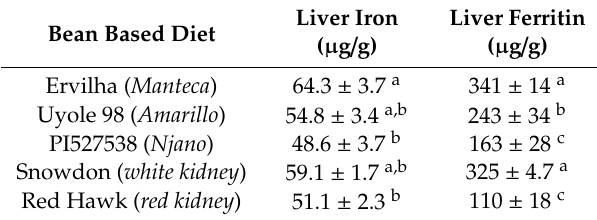
Table 7. Liver Iron and Ferritin Protein Concentrations After 6 Weeks of Consuming Bean Based Diets. 1 Bean Based Diet